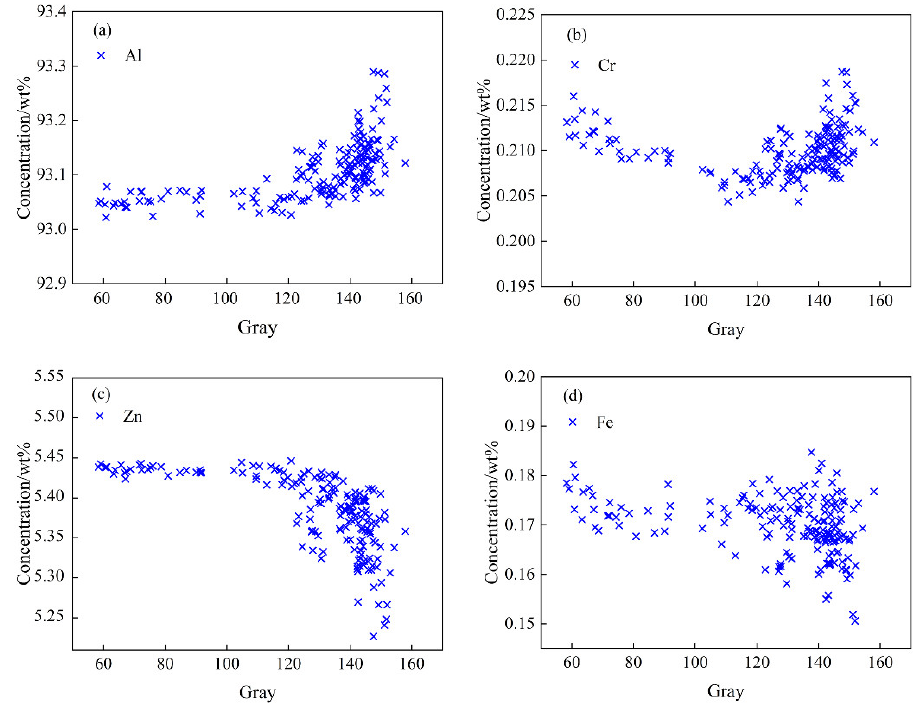
Figure 12. Statistical mapping diagram of gray and component in T5-10 aluminum alloy microregion. ( a ) Al element; ( b ) Cr element; ( c ) Zn element; ( d ) Fe element.